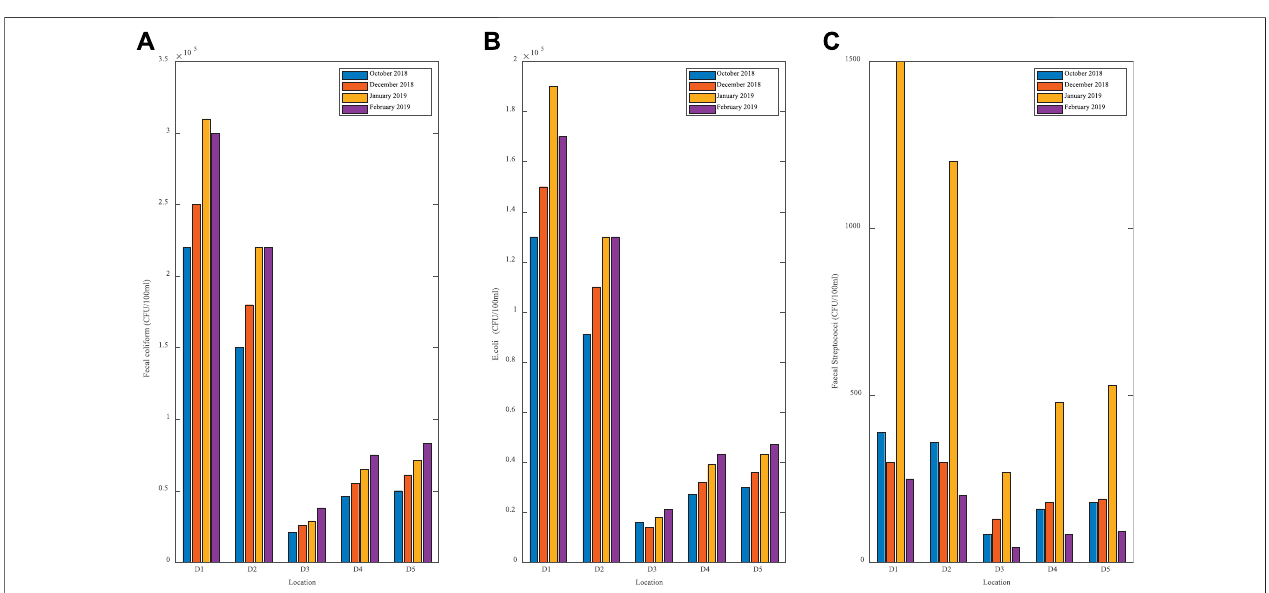
FIGURE 5 | Fecal coliform (A) , E. coli (B) , and fecal Streptococci (C) concentrations at the offshore locations.